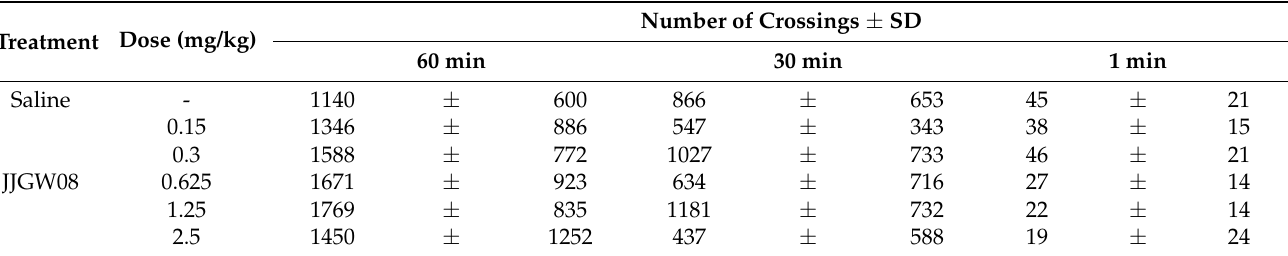
Figure 3. The effect of JJGW08 and aripiprazole on the number of buried marbles by mice. Mice were placed individually in cages with a 5 cm bedding layer, where 20 glass balls were placed. The number of buried marbles after 30 min of the test was counted. JJGW08 was administered intraperitoneally ( ip ) 30 min before the test. The control group received 0.9% NaCl solution ( ip ) or 1% Tween ( ip ) for aripiprazole. Values are expressed as means ± SD in the case of one-way ANOVA (aripiprazole) or median with interquartile range in the case of Kruskal–Wallis test (JJGW08), n = 8–10 mice per group. Statistical analysis: one-way ANOVA (Newman–Keuls post hoc ), and Kruskal–Wallis test (Dunn post hoc ), * p < 0.05, ** p < 0.01, *** p < 0.001. Table 4. The influence of JJGW08 on locomotor activity in